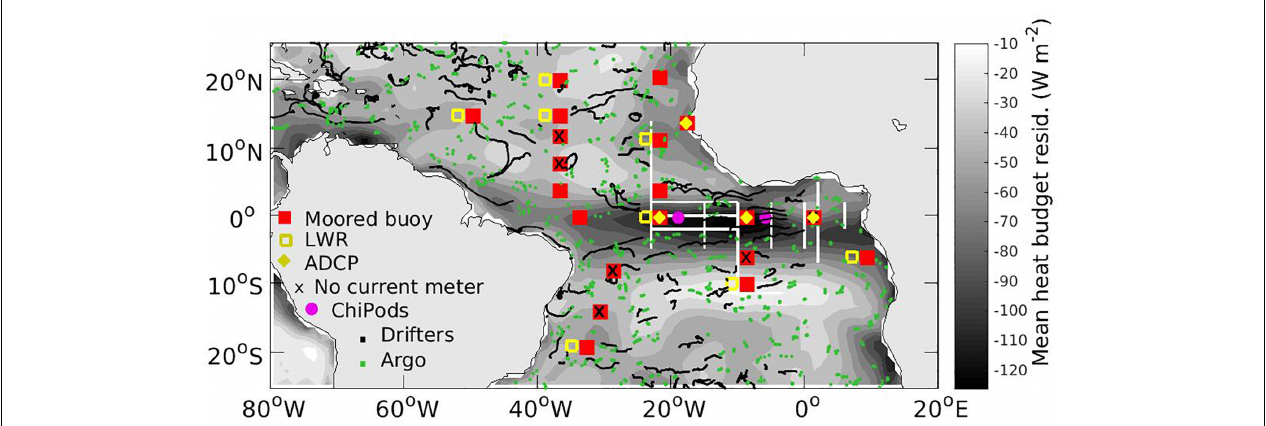
FIGURE 6 | Elements of the mixed layer heat budget and vertical mixing observing system. Black trajectories show the tracks of all surface drifters during August 2018. Green dots indicate locations of Argo floats in August 2018. Yellow squares and diamonds show mooring locations with longwave radiation sensors and ADCPs, respectively. Purple circles indicate locations with turbulence measurements, and a black ‘ x ’ indicates that the mooring does not have a near-surface current meter. Shading shows the annual mean heat budget residual (2003–2017), an estimate of the sum of horizontal heat advection and vertical turbulent cooling, calculated using TropFlux surface heat fluxes, blended satellite microwave-infrared SST, and mixed layer depth calculated from monthly gridded EN4 ocean temperature and salinity. White lines show the locations of ship-based and glider-based microstructure measurements conducted during